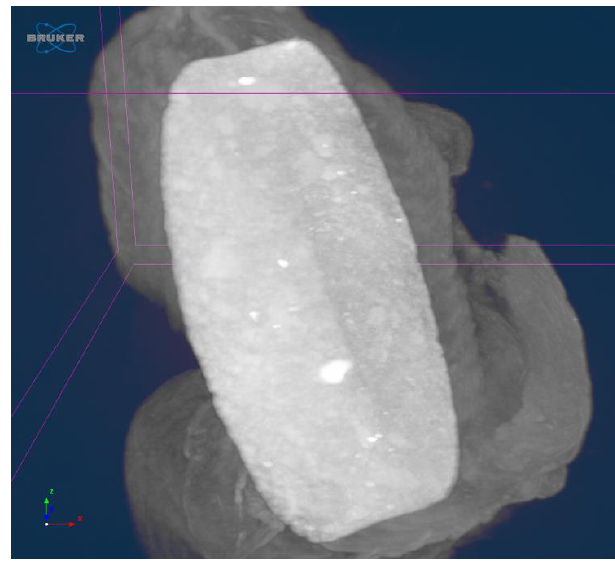
Figure 17. Tissue around IGF1 implant, 14 days, MicroCT image.